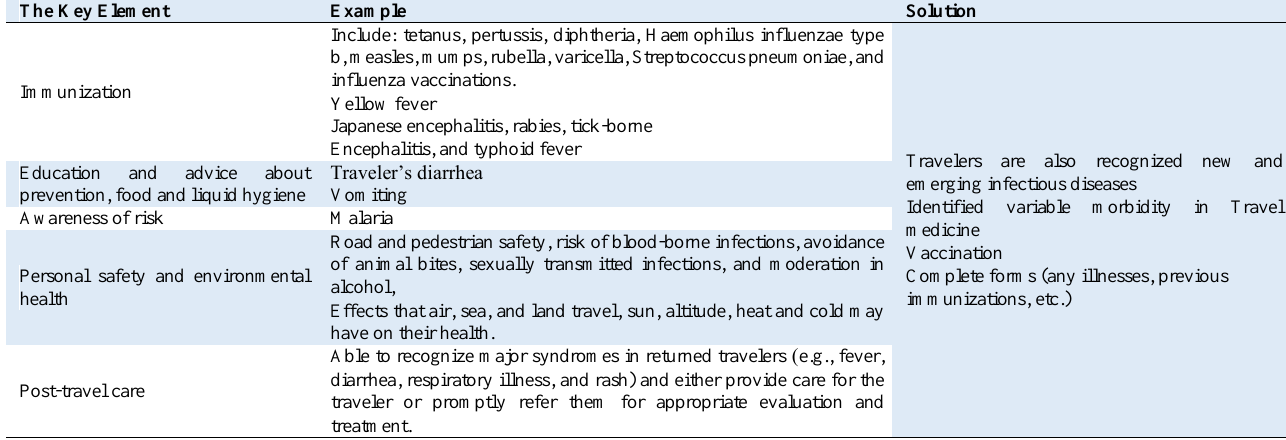
Table 1. The key element of the Travel medicine [11, 12, 13]